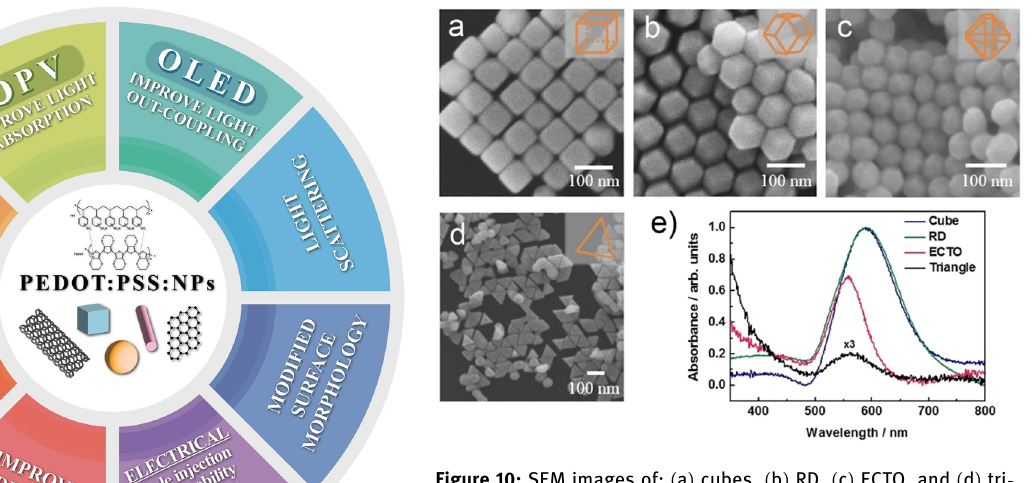
Figure 10: SEM images of: ( a ) cubes, ( b ) RD, ( c ) ECTO, and ( d ) tri - angular plates of AuNPs. ( e ) Absorption spectra of cubes, RD, ECTO, and triangular plates of AuNPs solutions [ 126 ] ; Copyright ( 2015 ) American Chemical Society.